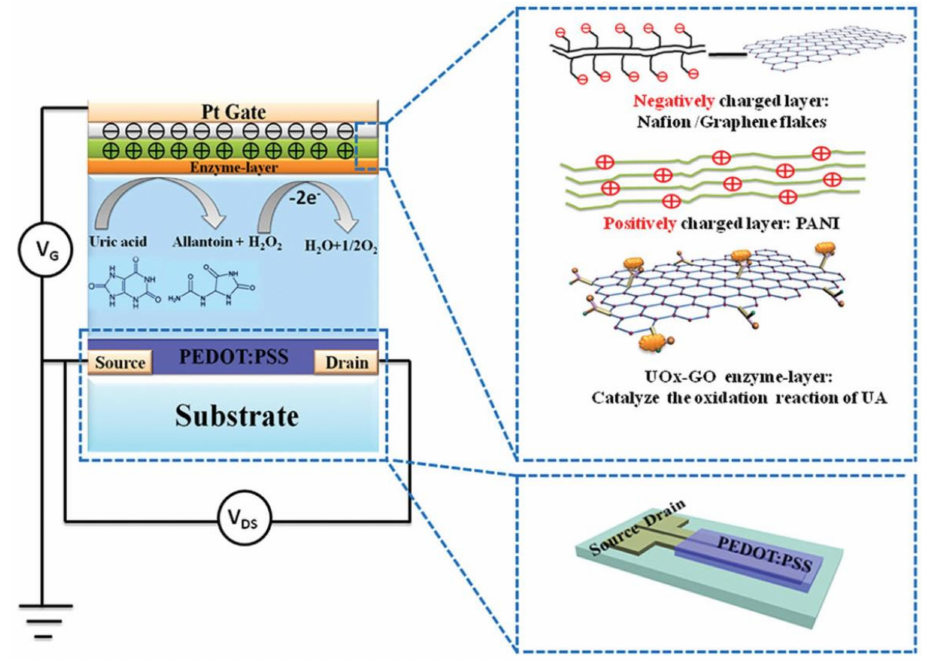
Figure 13. Schematic diagram of an OECT with a UOx-GO/PANI/Nafi on-graphene/Pt gate Reproduced from [99] with permission from John Wiley and Sons, Copyright ©